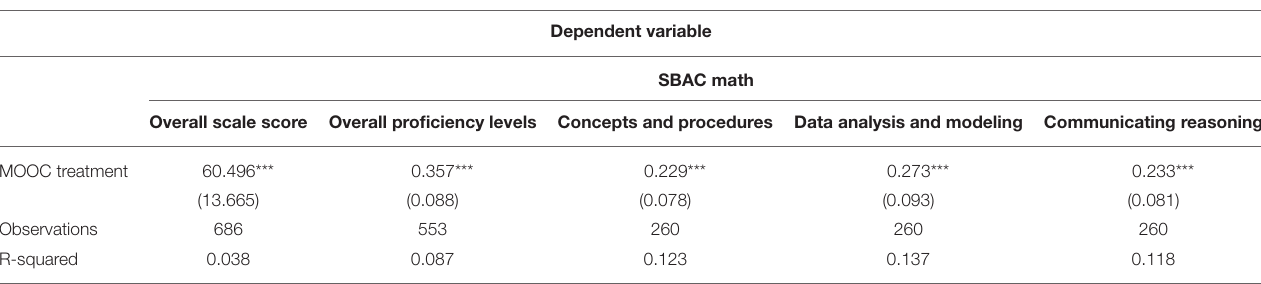
TABLE 4 | Regression estimates, MOOC effect on SBAC math